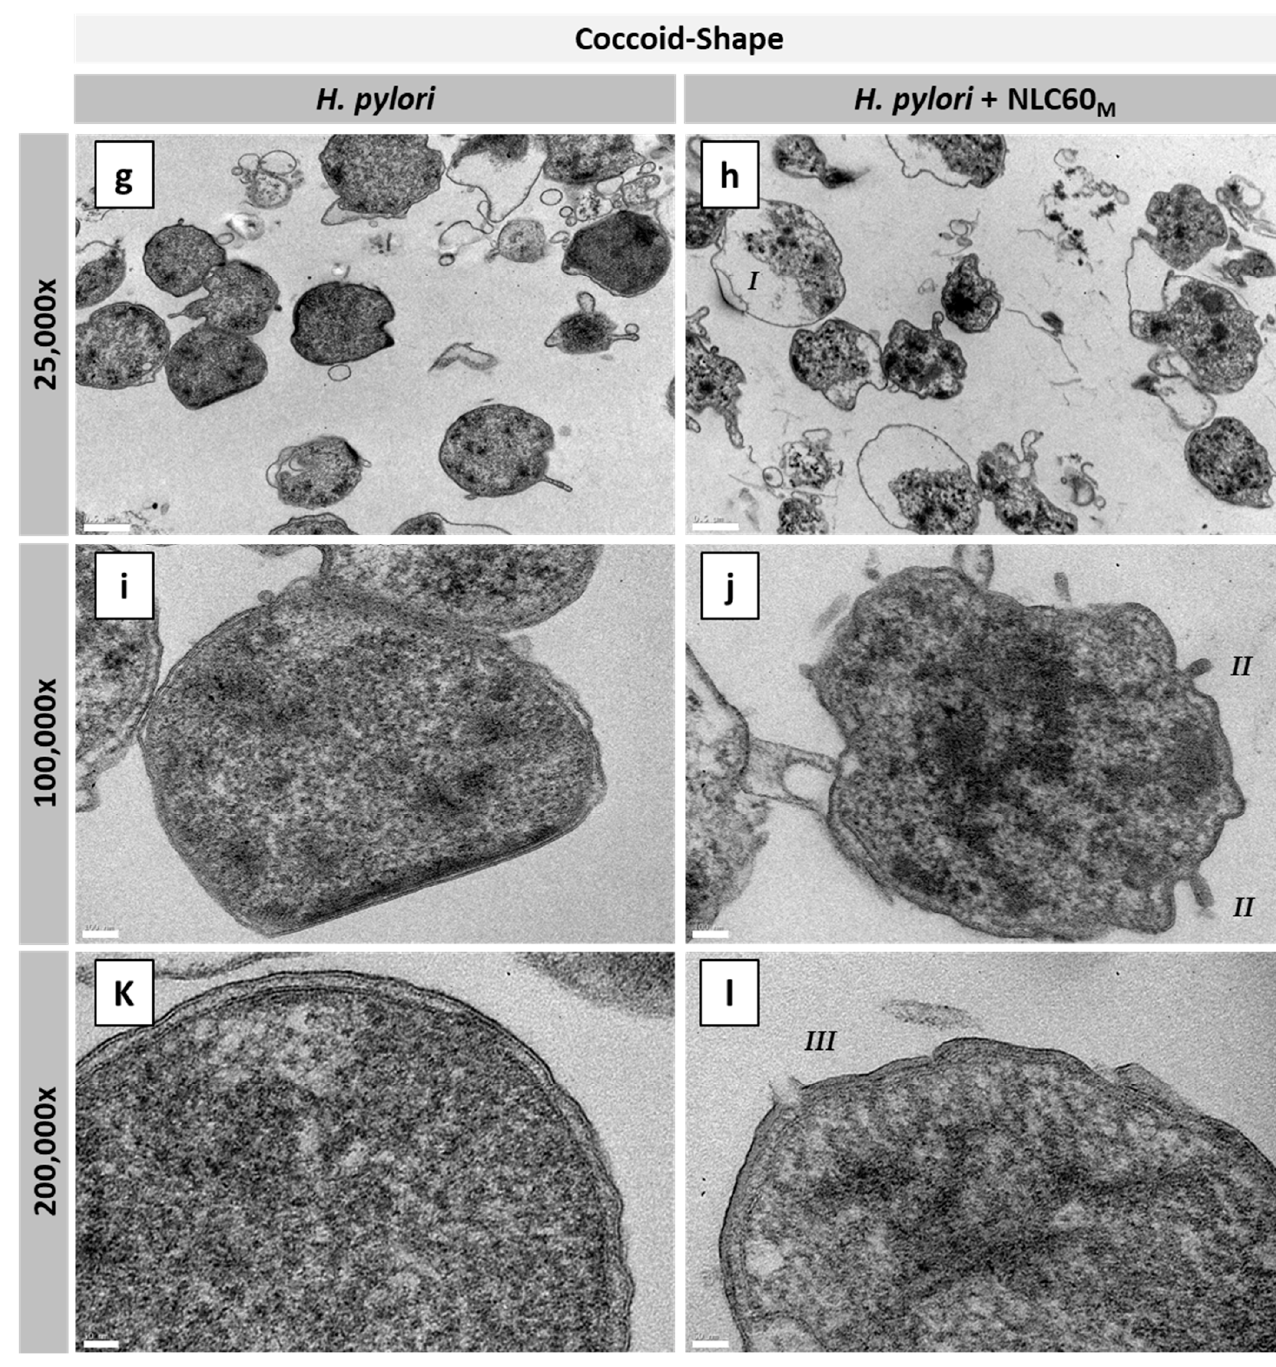
Figure 7. Transmission electron microscopy (TEM) micrographs of rod- and coccoid-shaped H. pylori J99 after 6 h of exposure to NLC60 M in PBS: ( a , c , e ) rod-shaped H. pylori control, ( b , d , f ) rod-shaped H. pylori exposed to NLC60 M (10 12 particles/mL), ( g , i , k ) coccoid-shaped control and ( h , j , l ) coccoid-shaped exposed to NLC60 M (10 12 particles/mL). Scale bars: ( a , b , g , h ) 500 nm; ( c , d ) 200nm; ( i , j ) 100 nm and ( e , f , k , l ) 50 nm. Arrows indicate: I —alterations in the cytoplasm; II —vesicle formation and III —membrane disruption.